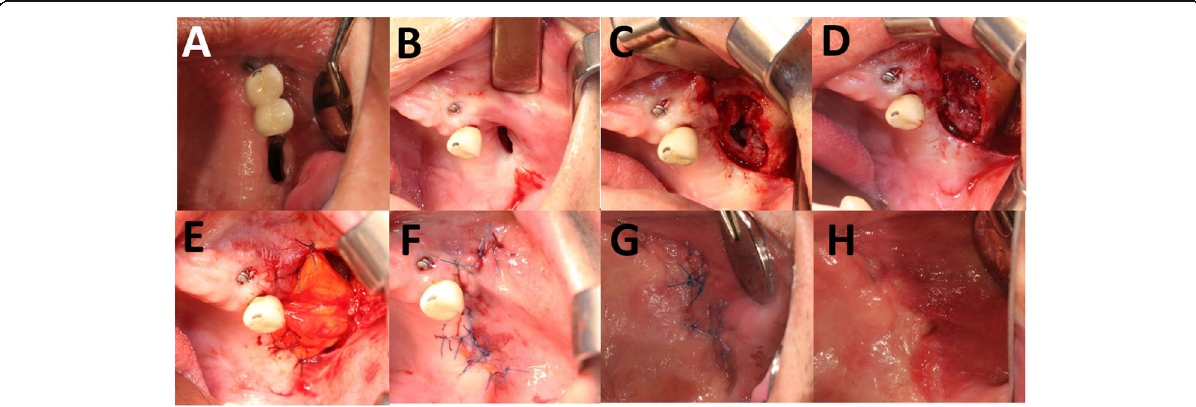
Fig. 1 The two-layer technique using a BFP and a buccal advancement flap. a At the first visit. b Pre-operative state. c After reflection of buccal gingiva. d After suture of sinus membrane. e Buccal fat pad graft on bony defect with suture. f After advanced buccal flap suture. g 1 week post- operative state. h 2 week post-operative